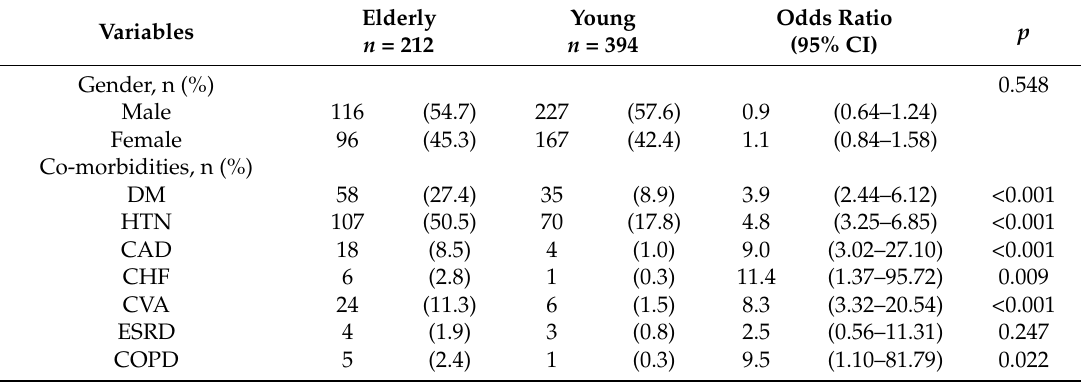
Table 1. Comparison of the characteristics and outcomes of the elderly and young adult patients with head AIS of